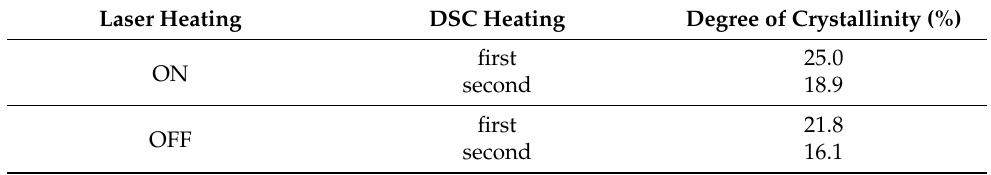
Table 10. Effect of laser heating during printing on crystallinity degree of PLA + 2% graphite